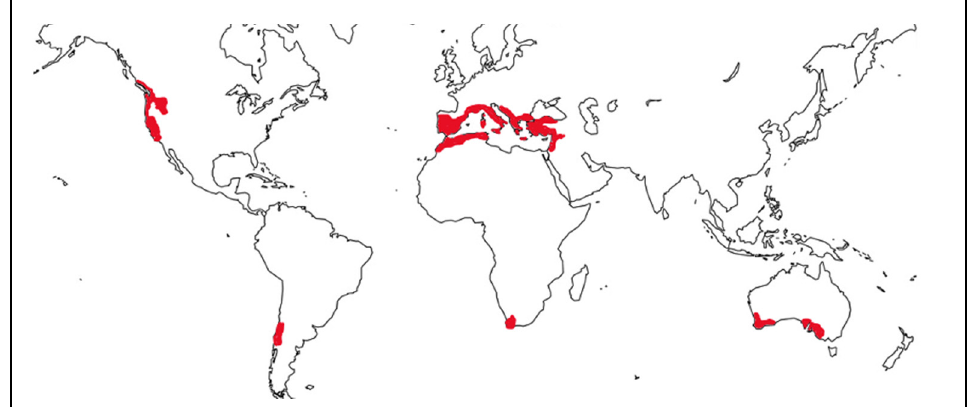
Figure 1. Geographic locations with a Mediterranean